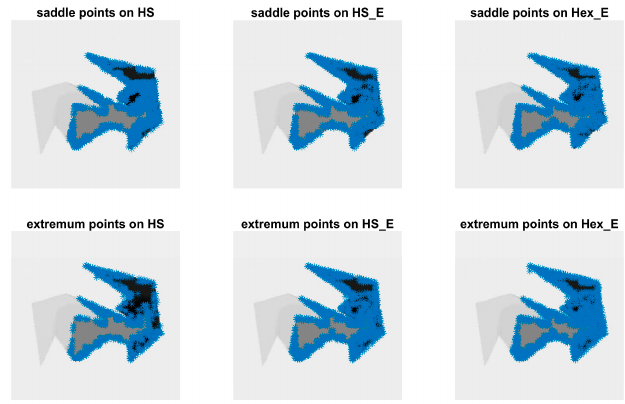
Figure 9. The detected saddle and extremum points on HS, HS_E and Hex_E images. Sensors 2018 , 18 , x